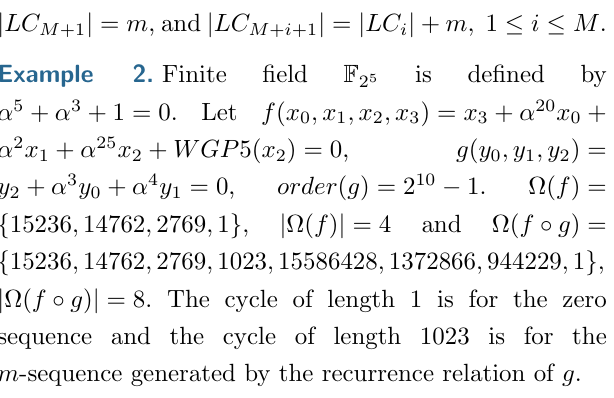
Figure 4. Distribution of the period ≥ n = 3 , (b) n = 4 g , denoted by f ◦ g , is defined as